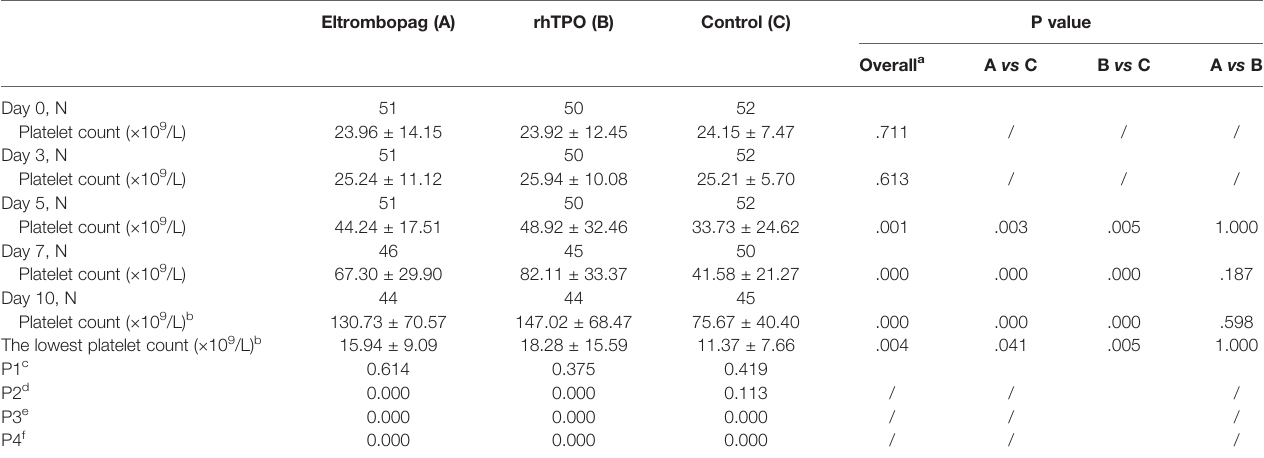
TABLE 2 | Platelet counts among the three